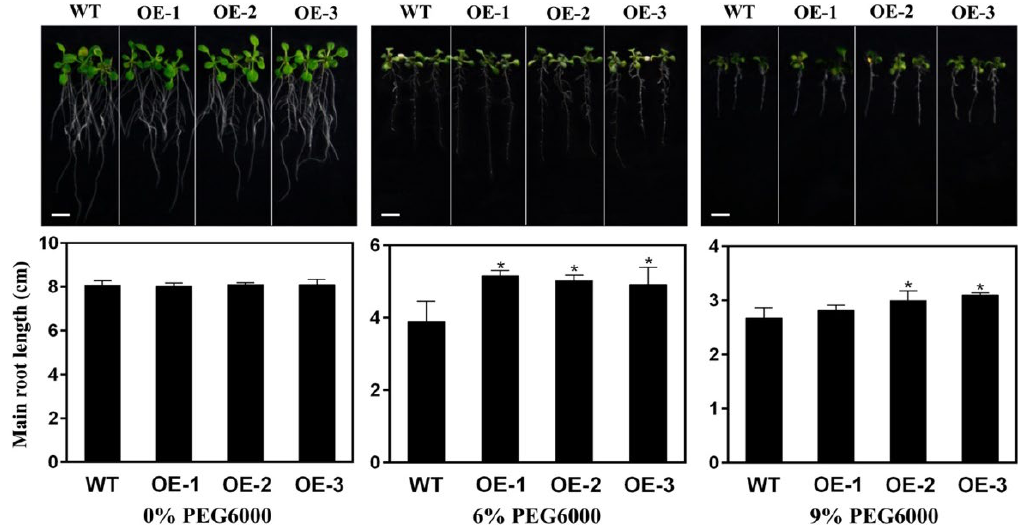
Figure 12. Root growth of three lines of transgenic Arabidopsis thaliana with overexpression of GmNAC3 (OE-1, OE-2, and OE-3) treated with PEG6000 of 0%, 6%, and 9%, respectively. The plants shown in the top panel correspond to the bar graphs presented in the bottom panel, respectively. Symbol “*” indicates significant differences at p values of 0.05 and 0.01, respectively. Bar = 1 cm.